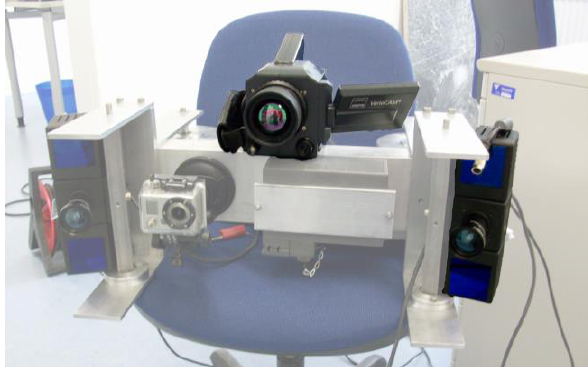
Figure 5. Segmented calibration marks of the TIR camera Figure 3. Camera rack with two TOF cameras (left and right), a (white) projected onto the segmented calibration marks of the RGB camera (lower center) and a thermal infrared camera TOF camera (black). Background: the estimated plane of the (upper center). The thermal camera Infratec VarioCAM hr and calibration table. the right TOF camera PMD[vision] CamCube 2.0 are used for the experiments.